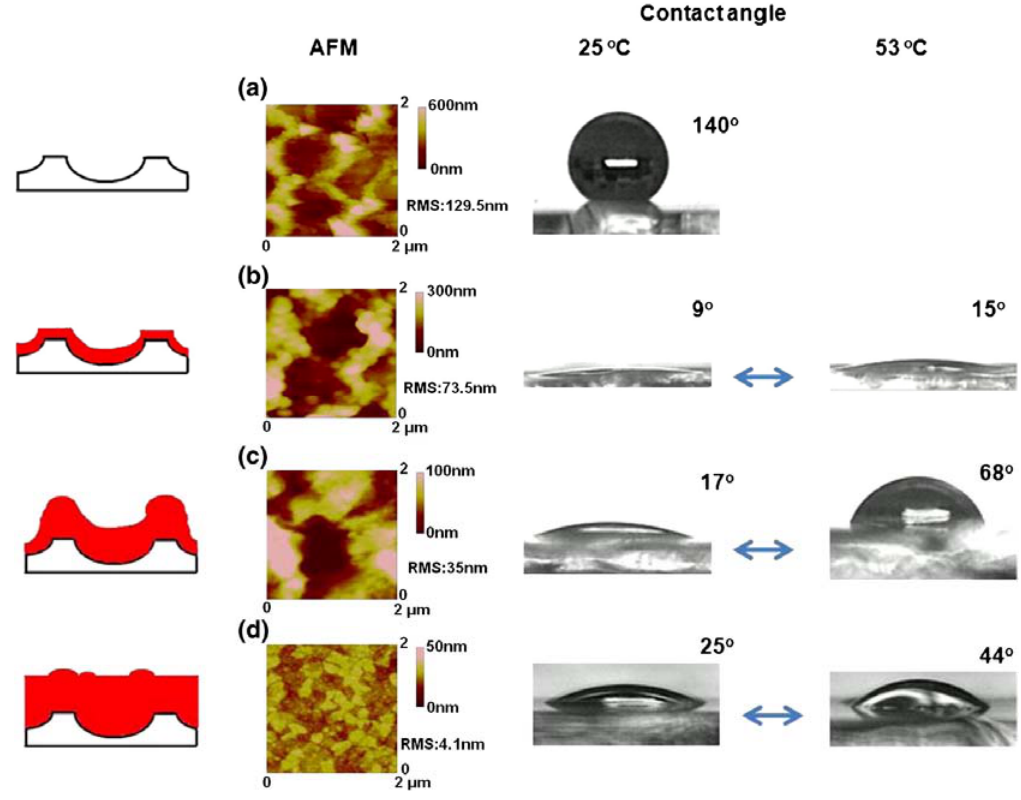
layer thickness, AFM images and thermally responsive wettability induced water droplet profile ( c ) S2; and ( d ) S3 substrates. Reprinted from Reference [231] with